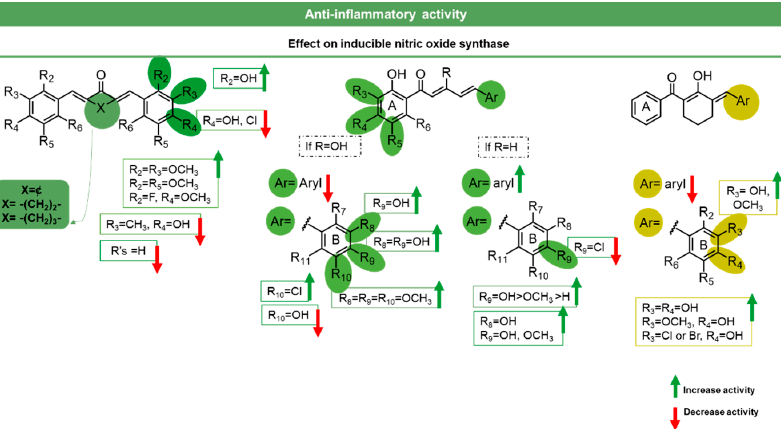
Figure 9. Putative SAR for the effects of diarylpentanoids with promising inhibition of NO